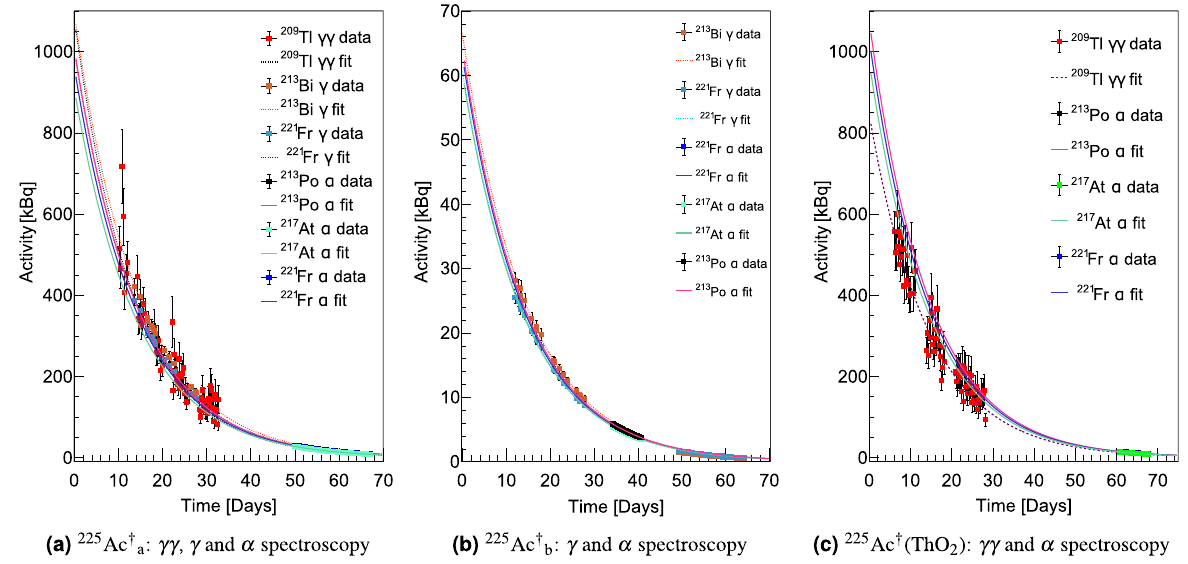
Figure 4. The activities of the three 225 Ac sources measured by decay